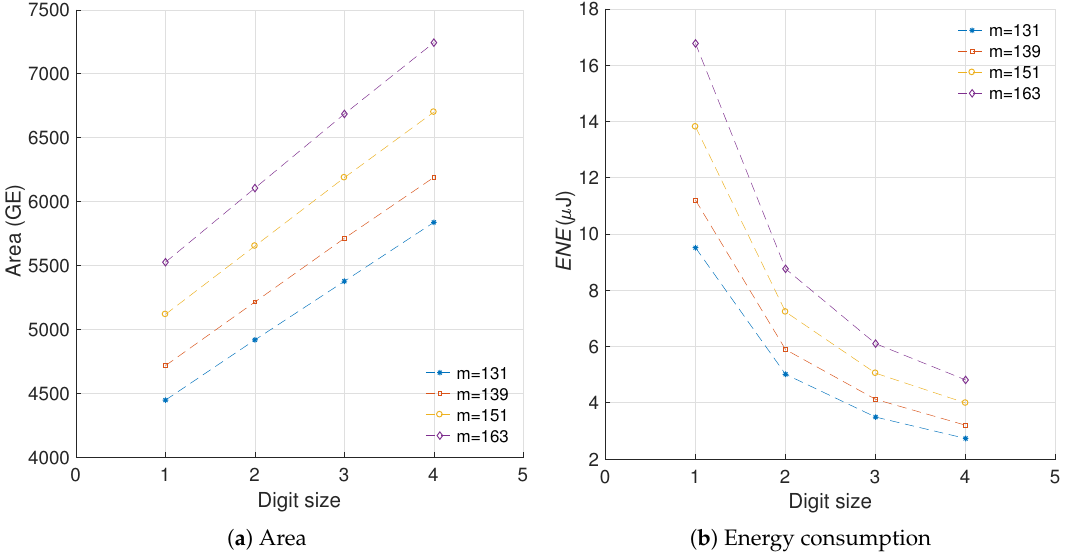
Figure 11. Implementation results for the architectures in [22].